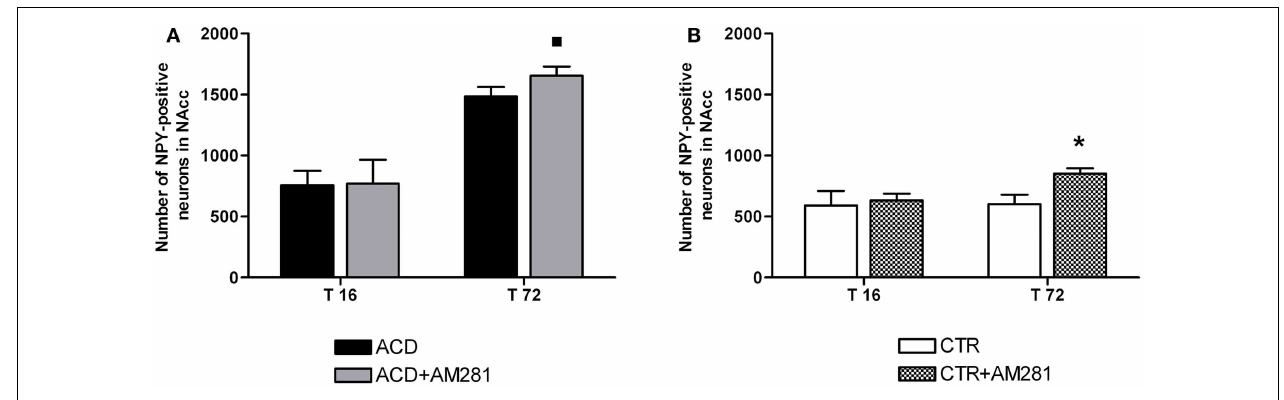
FIGURE 7 | Effect ofAM281 treatment on the number of nucleus accumbens neuropeptideY (NPY)-positive neurons inACD rats (A) and in controls (B) . Each value represents the mean ± S.D. of 12 sections for each experimental condition. * p < 0.001; (cid:4) p < 0.01 vs respective